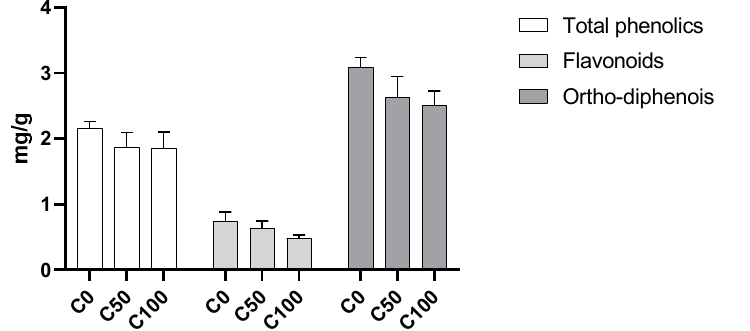
Figure 1. Total phenolic content (mg GAE/g), total flavonoid content (mg CE/g) and ortho-diphenols content (mg CAE/g DW). C0—control treatment with water; C50, Superfifty at 0.5 L/ha; C100, Superfifty at 1 L/ha.